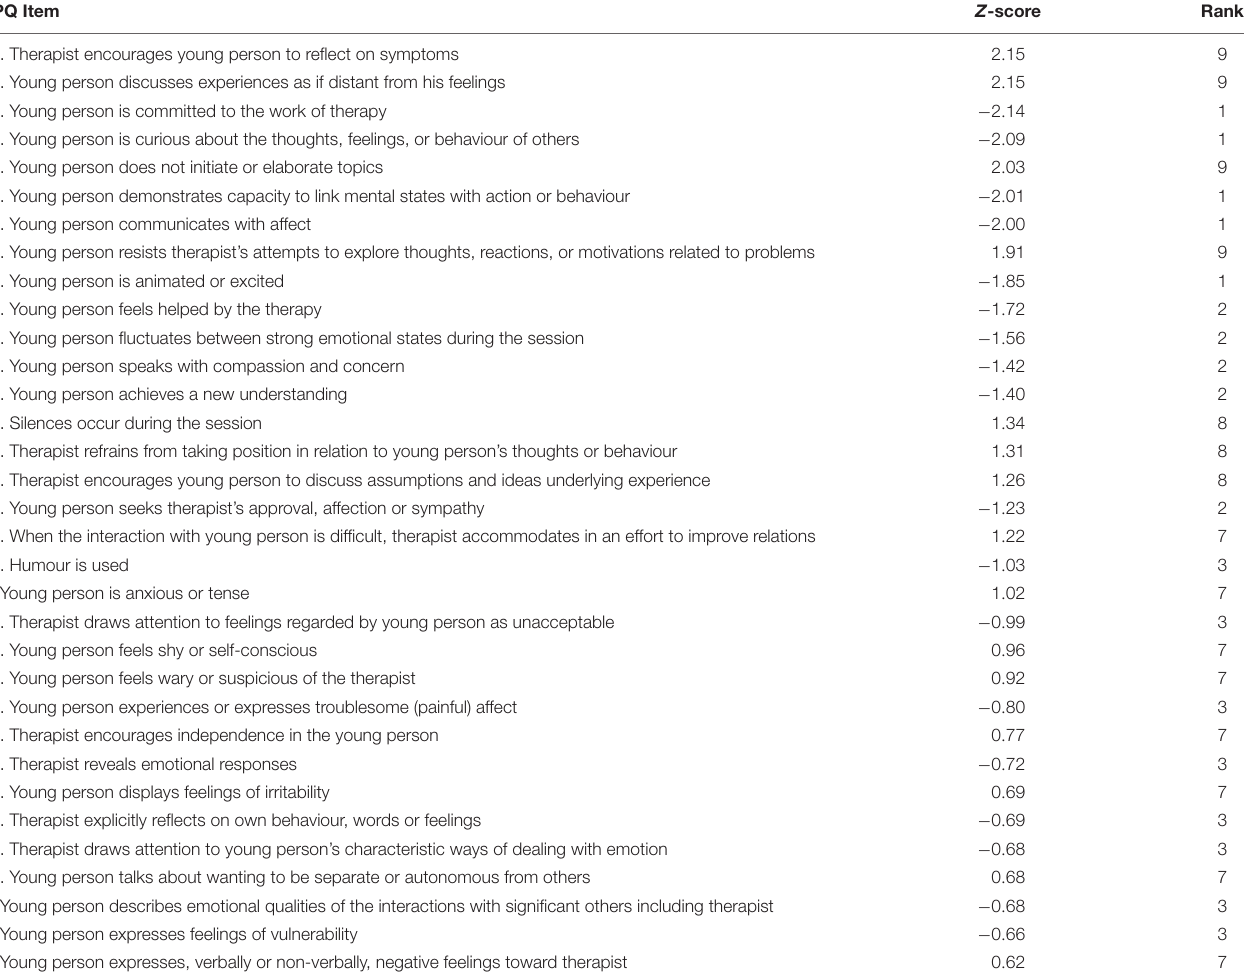
TABLE 4 | Interaction structure 2: “Resistance and emotional detachment.” APQ Item Z -score